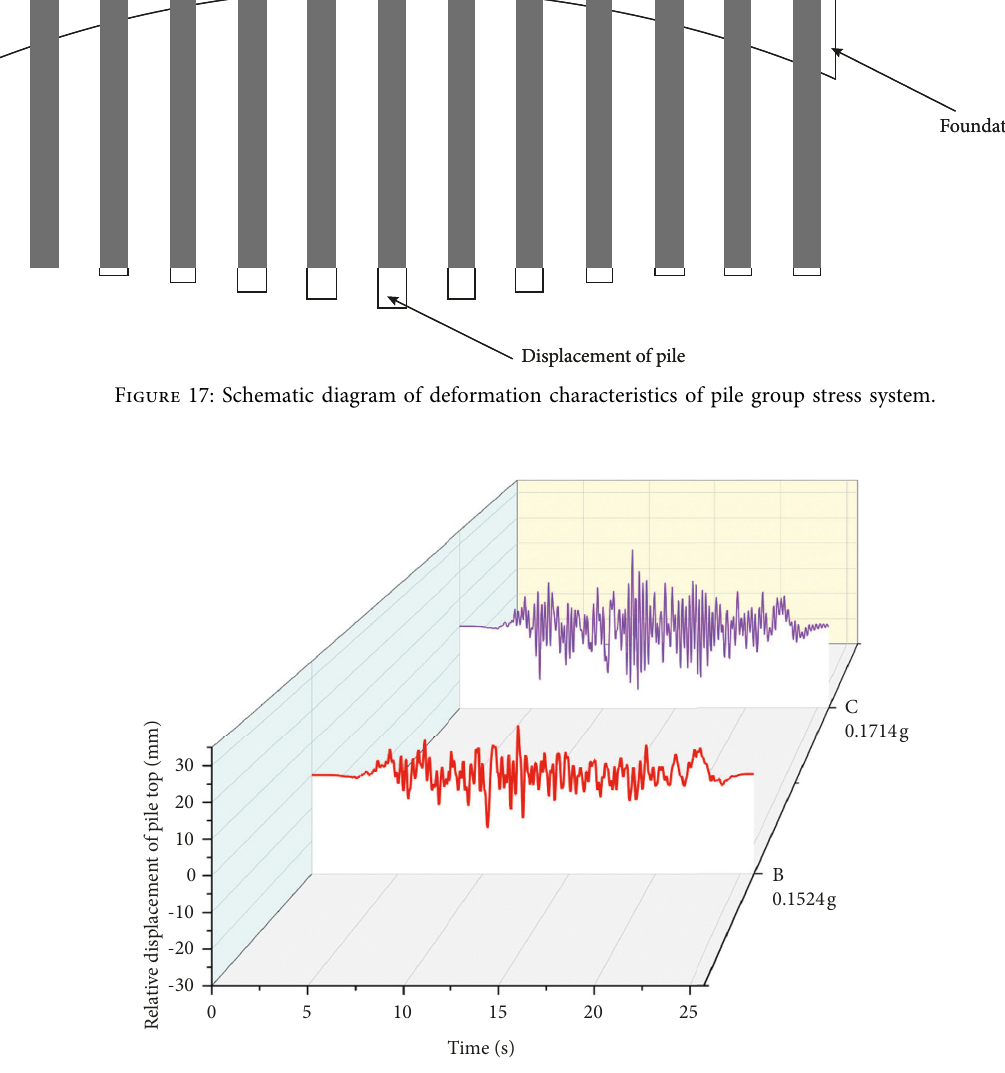
Figure 18: Relative displacement of pile top.